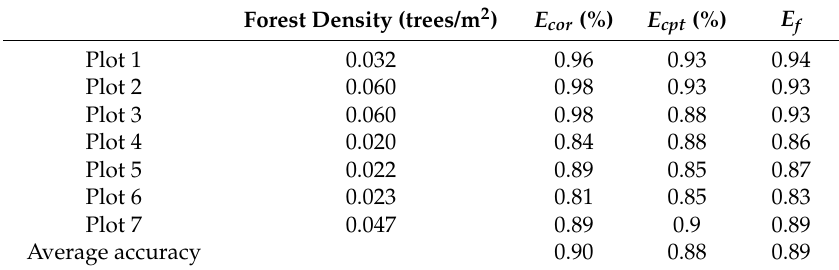
Table 5. Single tree segmentation results by our